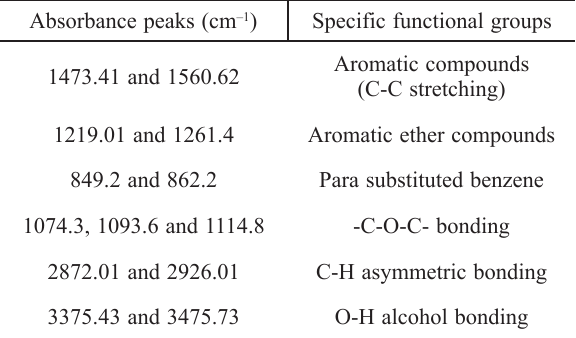
Table 2 – Specific functional groups as shown in FT-IR spectra